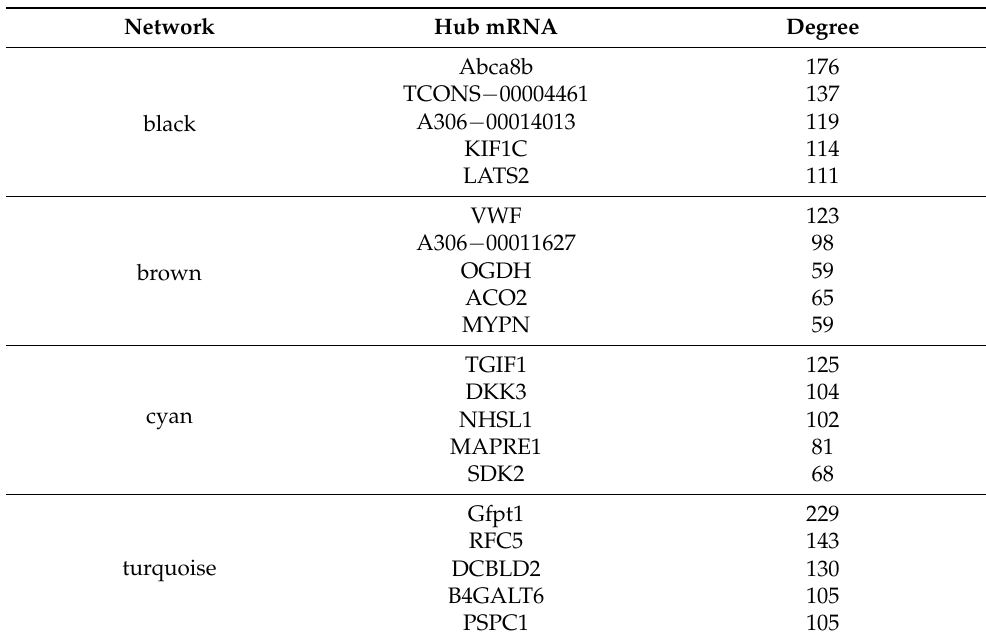
Table 3. Hub genes in the four